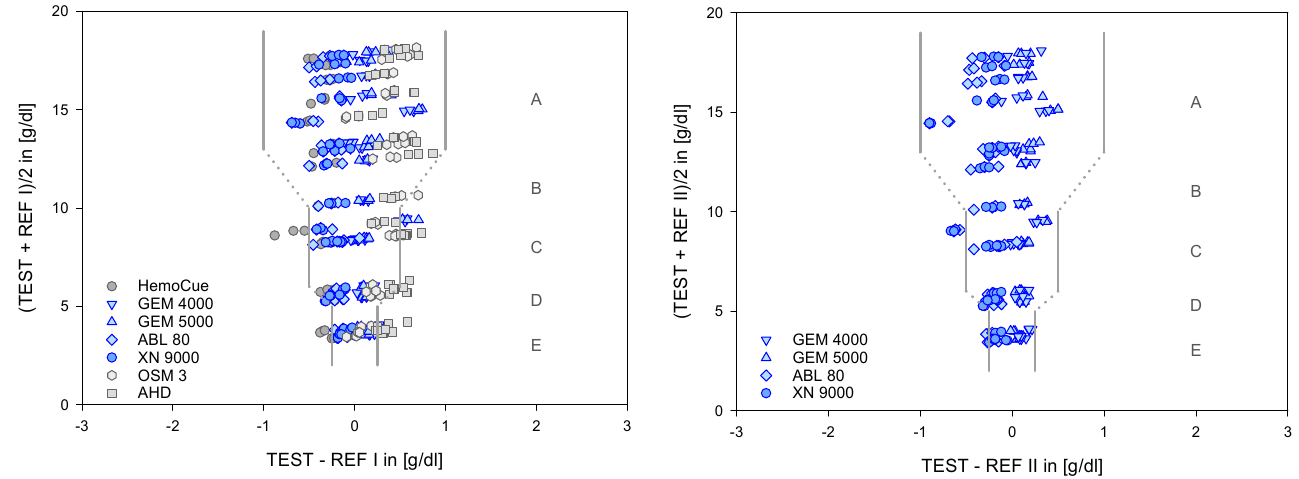
Figure 6. Data plot according to the tolerance level analysis (TLA). The measurement accuracy should be within the limits shown. Zone A represents the requirements for detecting anemia, zone C is defined by the accuracy requirements for patent blood management, zone E is defined as the critically low area requiring the most accurate measurements. Zones B and D represent a seamless transition between the critical zones, according to [7].